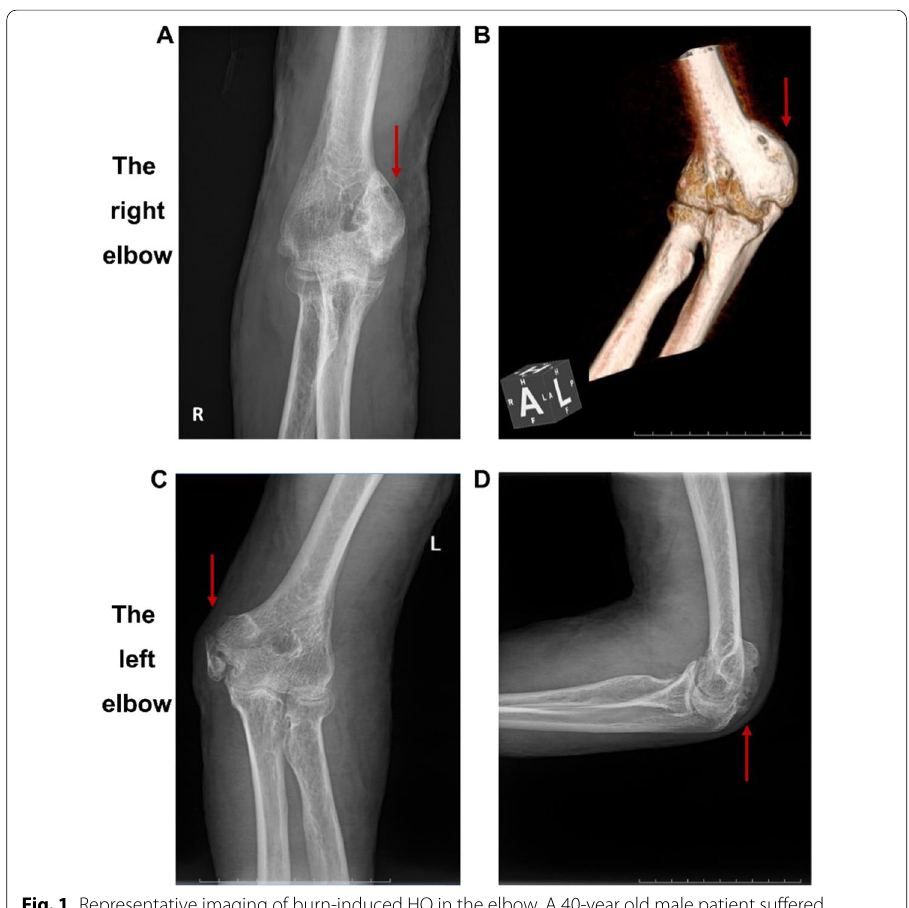
Fig. 1 Representative imaging of burn-induced HO in the elbow. A 40-year old male patient suffered extensive thermal burn injury (80% TBSA). He complained of limitation in the range of movement of his bilateral elbow joints 3 months after the burn injury. He was diagnosed with burn-induced HO of both elbows via imaging examinations. A X-ray of the right elbow. B 3D reconstruction of CT on the right elbow. C , D X-rays of the left elbow. The red arrows indicate the HO